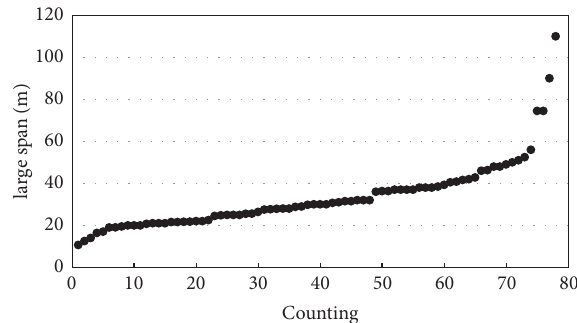
Figure 1: Largest span of analyzed footbridges (circular ribbon footbridge not